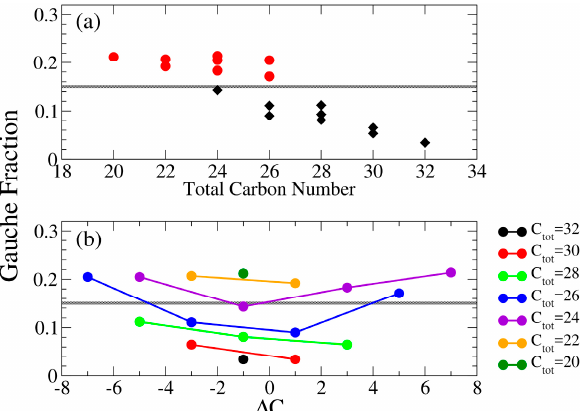
Figure 9. Averaged gauche fraction value of middle segments plotted with respect to ( a ) the total alkyl carbon number (top panel) in which bilayers in S and Ld phases are colored in black diamonds and red dots, respectively, and ( b ) Δ C (bottom panel) in which each line represents systems with equal total alkyl carbon numbers. The gray lines represent the threshold gauche fraction value of 0.15 to distinguish the Ld and S phases.